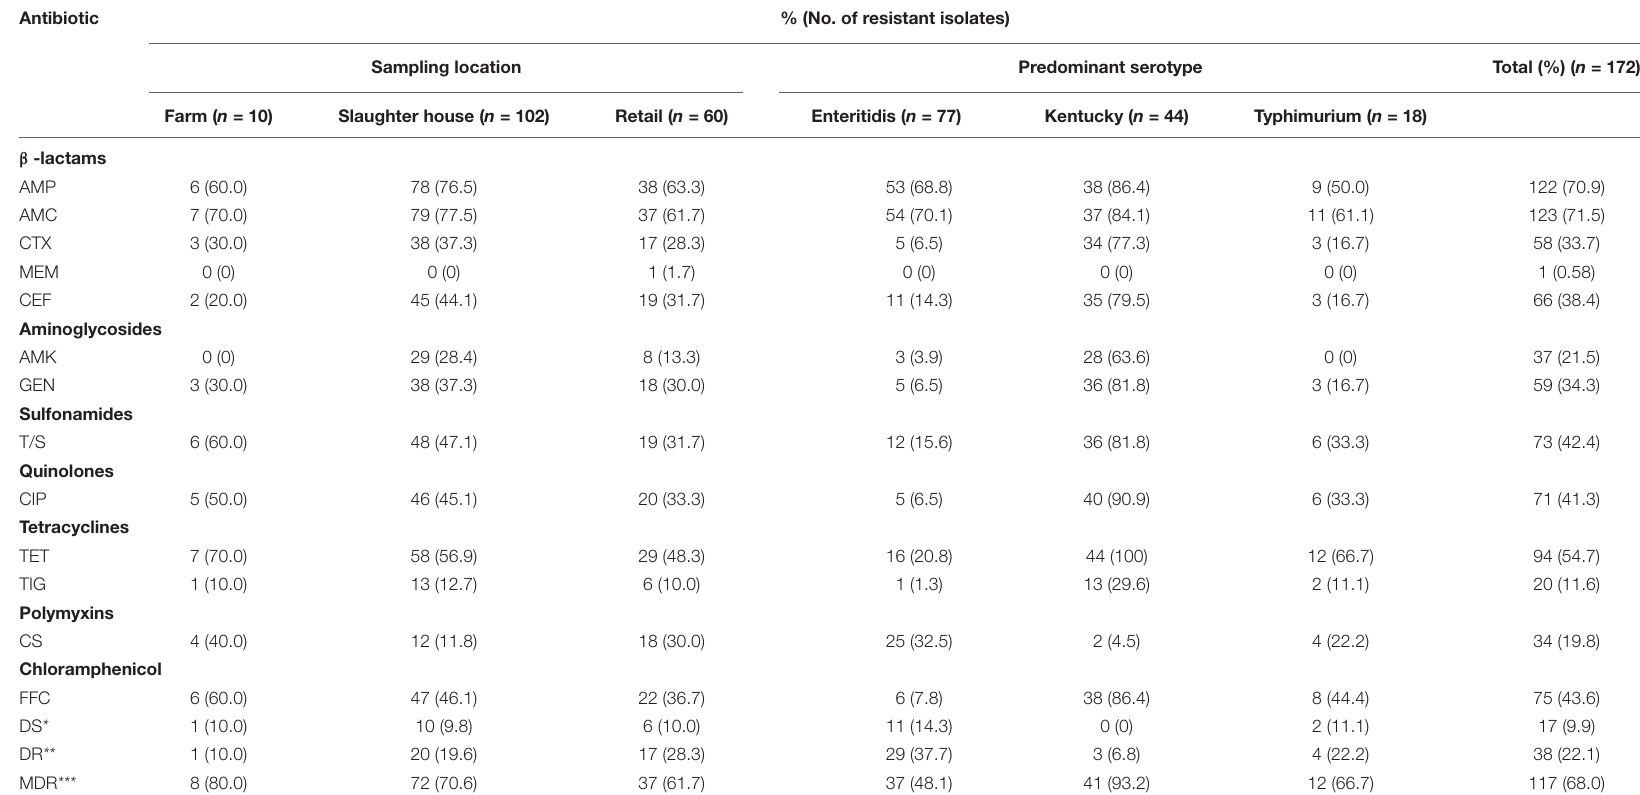
TABLE 3 | Frequency (% of total isolates) of resistance to antibiotic agents among Salmonella isolates from poultry supply chains. Antibiotic % (No. of resistant isolates) Sampling location Predominant